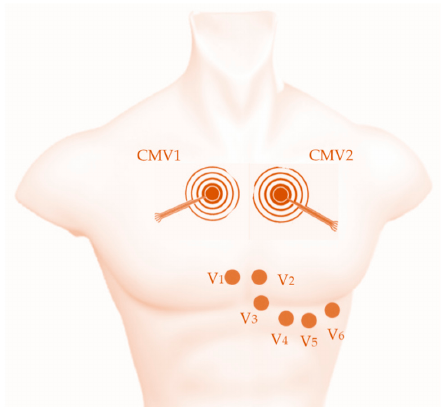
Figure 2. Scheme of the electrode placement for conventional disc electrodes in precordial positions V1, V2, V3, V4, V5, and V6 and two CREs in positions CMV1 (comparable to V1) and CMV2 (comparable to V2) for ECG recording.